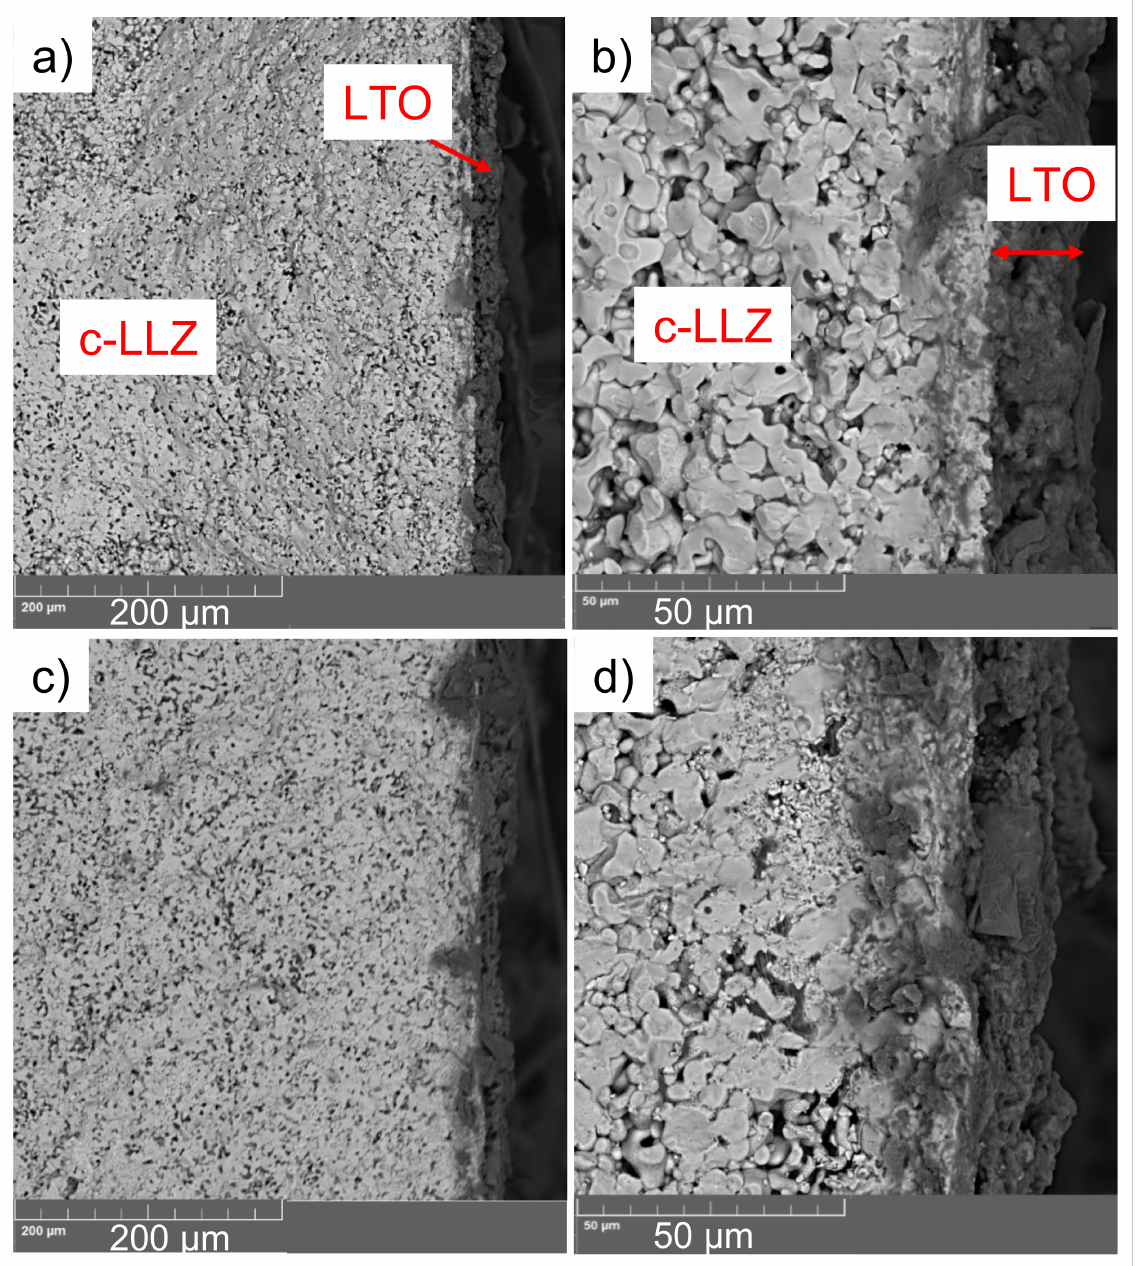
Figure 9. SEM images of the cross-section of Li 4 Ti 5 O 12 |c-LLZ ( a , b ) and Li 4 Ti 5 O 12 + 5 wt% Li 3 BO 3 |c-LLZ ( c , d ), after heating at 720 ◦